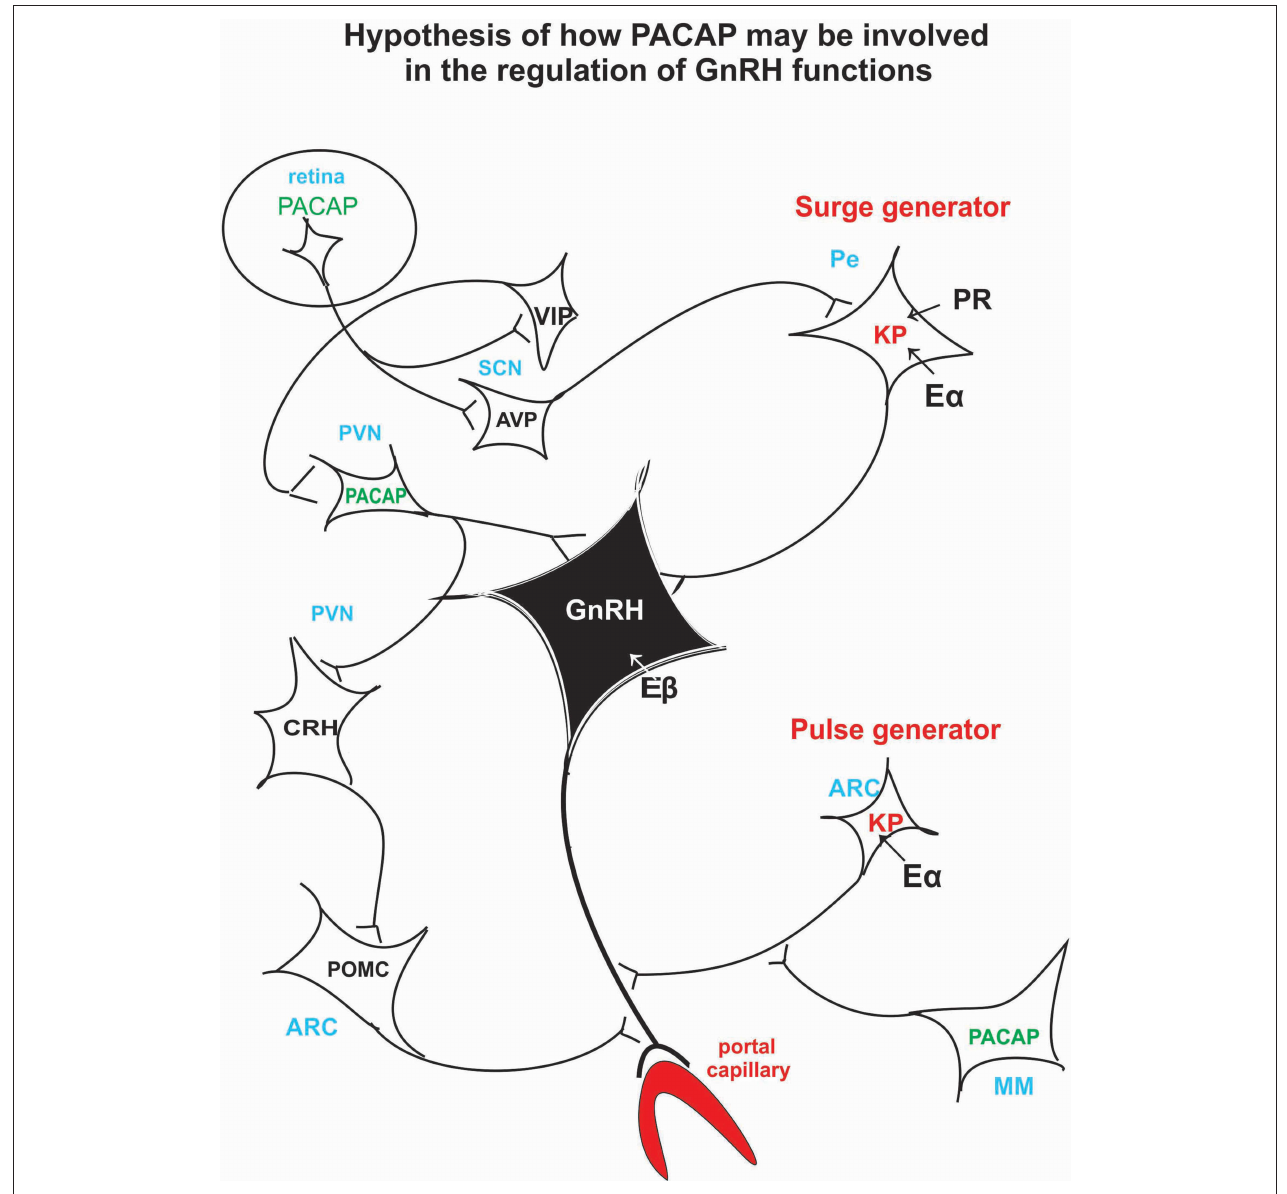
FIGURE 3 | Schematic illustration of the hypothetical pathway of how PACAP may be involved in the regulation of the GnRH release. Retinal PACAP may influence AVP and VIP cells located in the suprachiasmatic nucleus (biological clock). AVP fibers terminate on KP neurons which create the surge generator. PACAP neurons, located in PV, may receive information from the suprachiasmatic VIP neurons. PACAP may exert its effect directly on GnRH cell bodies or via CRH and POMC neurons on GnRH axons. PACAP neurons residing in MM may influence KP neurons which create the “pulse generator.” ARC, arcuate nucleus; AVP, arginine vasopressin; CRH, corticotropic hormone-releasing hormone; E α , estrogen receptor alpha; E β , estrogen receptor beta; GnRH, gonadotropic hormone-releasing hormone; KP, kisspeptin; MM, medial mammillary nucleus; PACAP, pituitary adenylate cyclase activating polypeptide; Pe, periventricular area; POMC, proopiomelanocortin; PR, progesterone receptor; PVN, paraventricular nucleus; SCN, suprachiasmatic nucleus; VIP, vasoactive intestinal polypeptide.